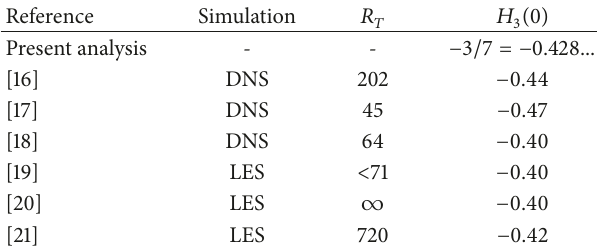
Table 1: Comparison of the results: skewness of 𝜕𝑢 𝑟 /𝜕𝑟 at diverse Taylor scale Reynolds number 𝑅 𝑇 ≡ 𝑢𝜆 𝑇 / ] following different